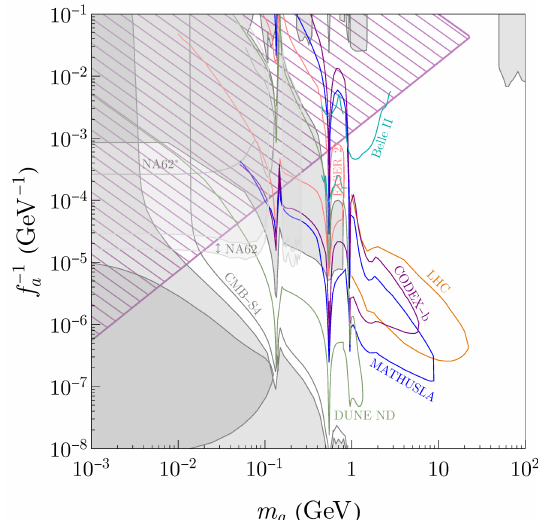
Figure 2 . The purple hatched region shows the viable parameter space where the baryon asym- metry can be explained by axiogenesis with a heavy QCD axion, specifically for the case where the axion mass is suppressed at the electroweak phase transition because the radial component has not yet settled to the minimum of the